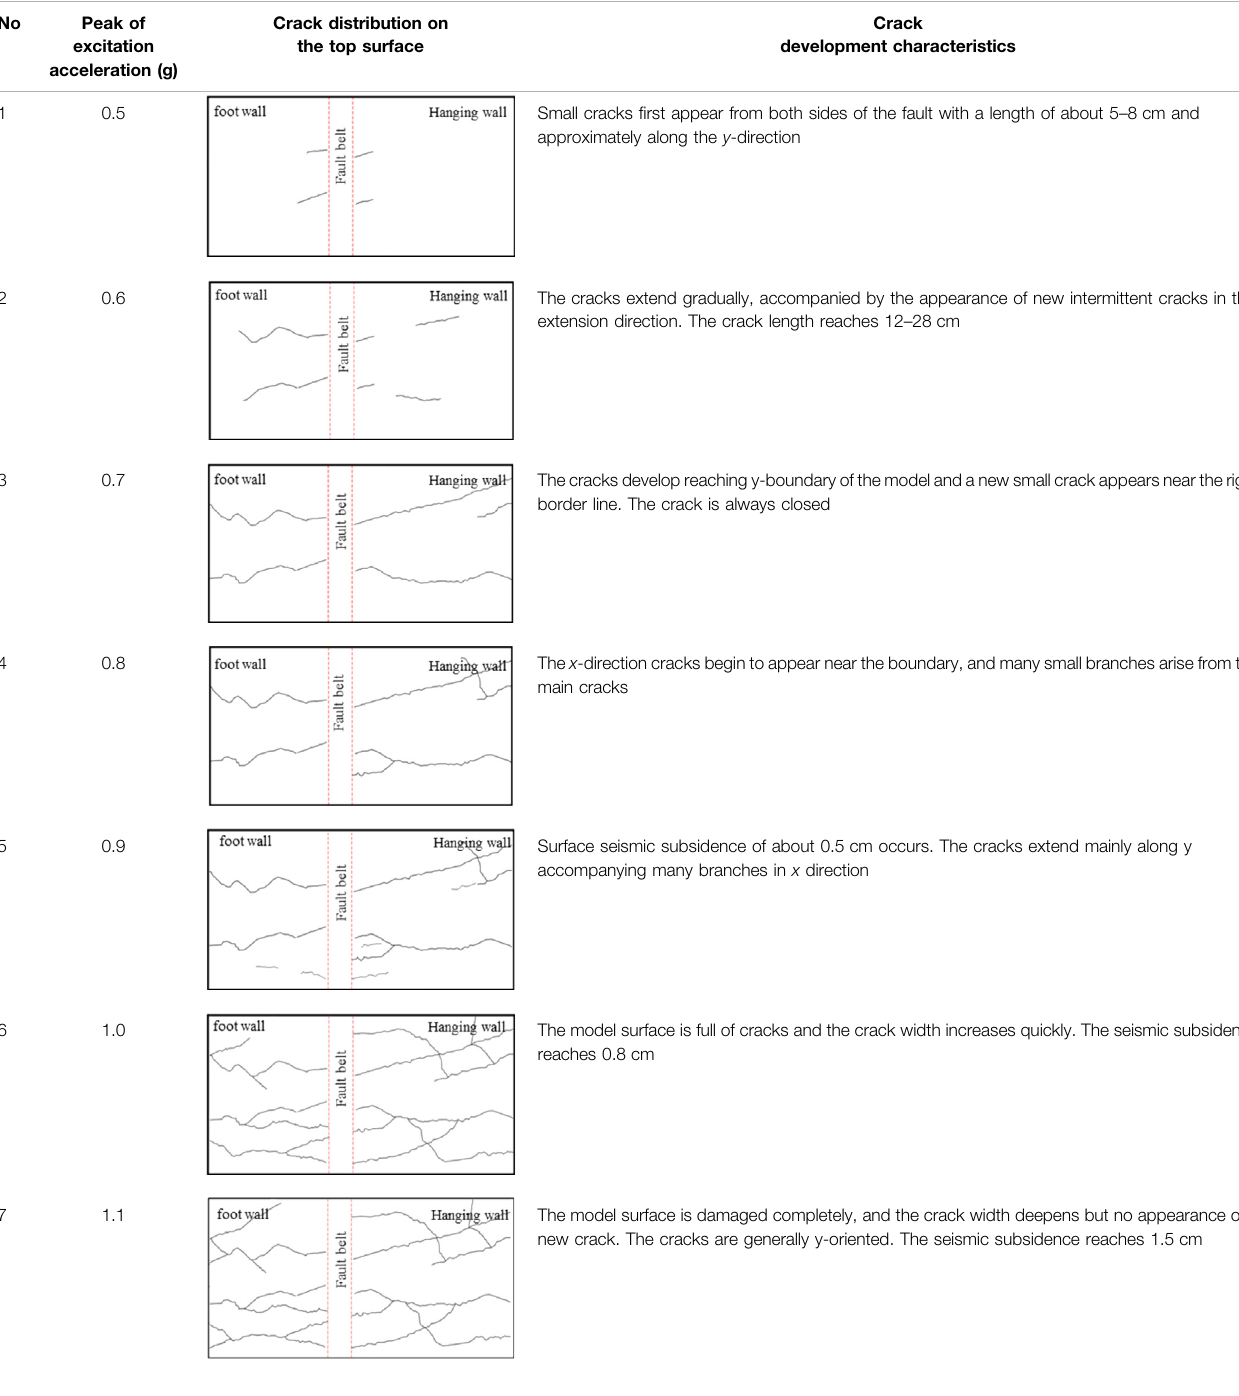
TABLE 4 | Crack characteristics of the model top